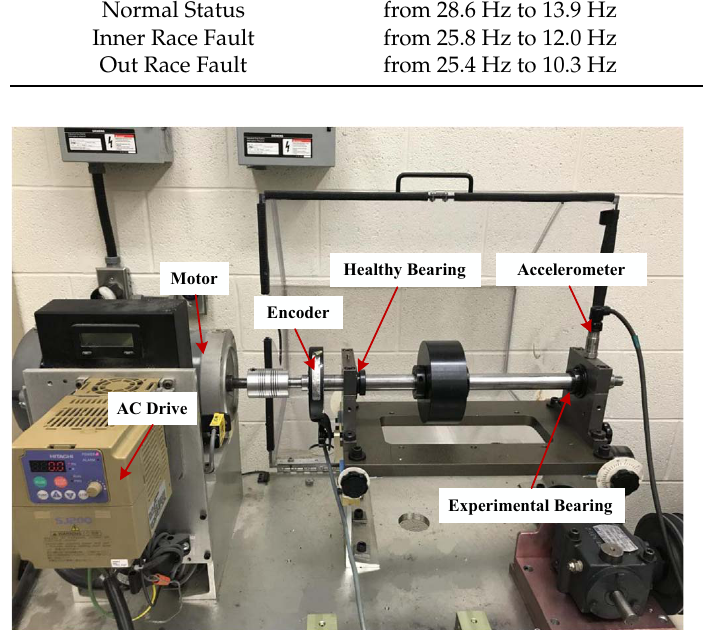
Fig. 1. Experimental set-up. Figure 6. Time-varying bearing experimental device at the University of